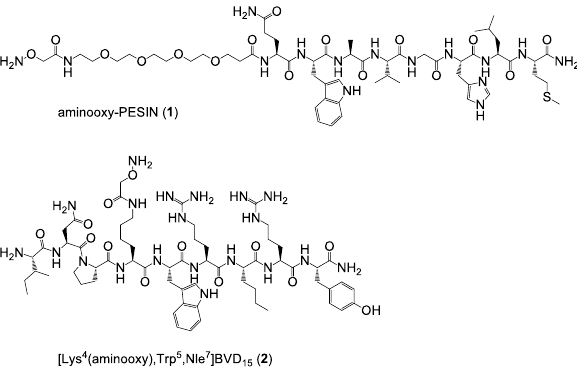
Figure 3. Depiction of the chemical structures of aminooxy-PESIN ( 1 ) and [Lys 4 (aminooxy),Trp 5 , Nle 7 ]BVD 15 ( 2 ) used for the assembly of the HBPLs.